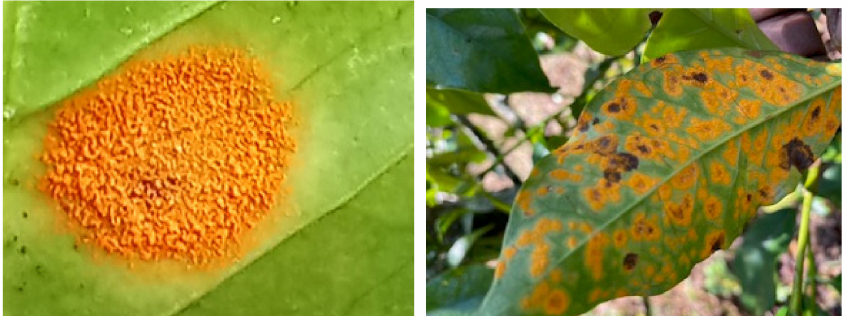
Figure 2. An active fully expanded CLR Lesion ( left ) and advanced stages of Coffee Leaf Rust infection showing coalesced lesions and necrotic centers ( right ).